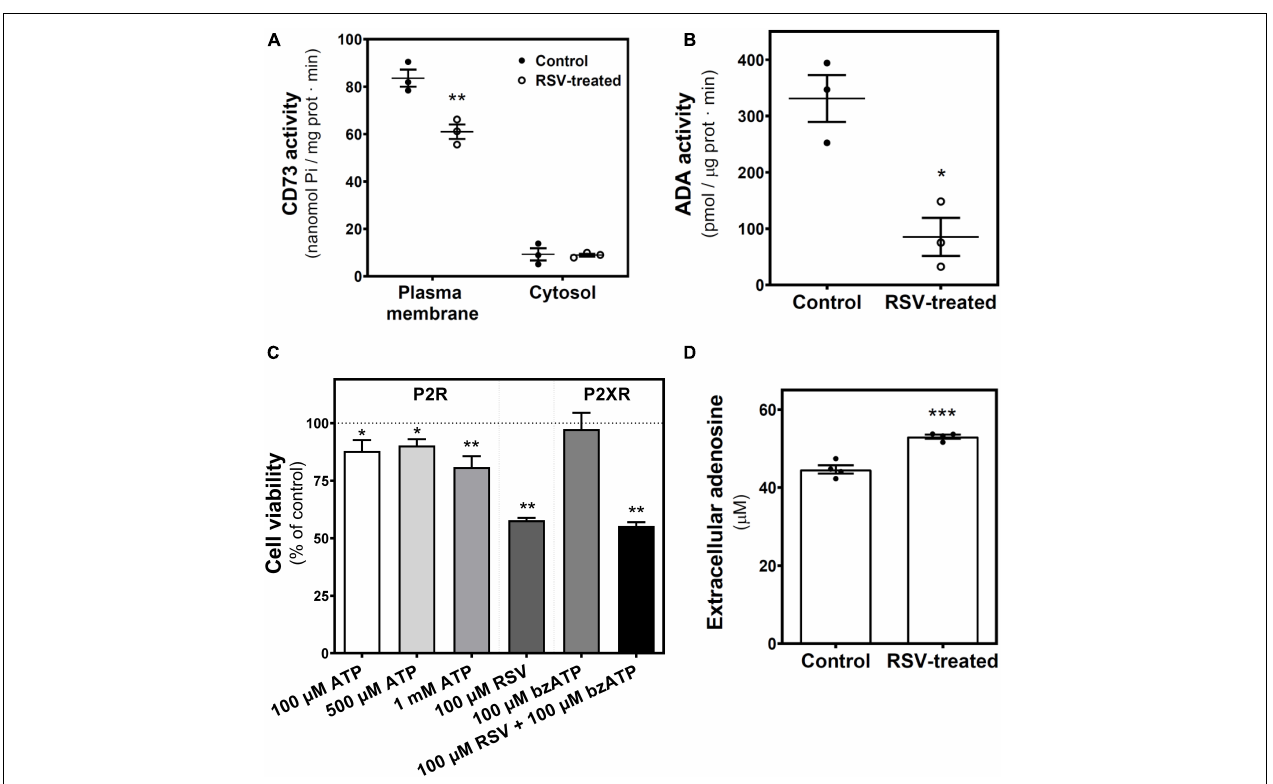
FIGURE 5 | RSV treatment effect on adenosine-related enzymatic activities. 5 (cid:48) -nucleotidase (CD73) and ADA activities were measured in control and 24 h RSV-treated C6 cells. (A) 5 (cid:48) -nucleotidase activity localized in the plasma membrane and cytosolic fraction were assayed and represented as nmol Pi/mg prot · min. (B) ADA activity was quantified and represented as pmol/ µ g prot · min. (C) Cell viability based on the XTT method was performed after 24 h of treatment with the indicated ligands. (D) Quantification of adenosine levels in culture medium by HPLC. Data are means ± SEM of three to five independent experiments. * p < 0.05, ** p < 0.01, and *** p < 0.001 significantly different from the control condition according to Student’s t